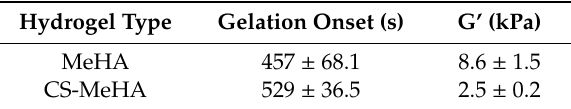
Table 2. Gelation onset time and storage modulus (G’) of methacrylated hyaluronic acid (MeHA) and chondroitin sulfate-methacrylated hyaluronic acid (CS-MeHA) hydrogels (5 w / v%) formed using a matrix metalloproteinase 7 (MMP7)-degradable peptide as a crosslinker in the presence of DMEM. Results are presented as mean values of three measurements ± the respective standard error.